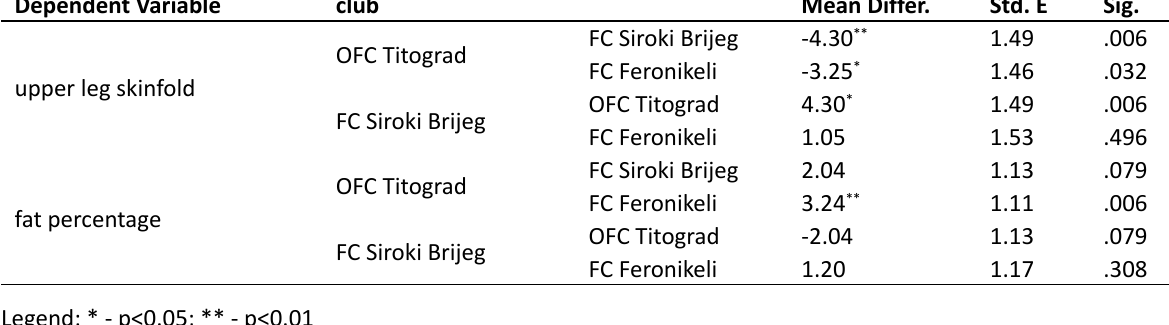
Table 2. LSD Post Hoc tests Dependent Variable